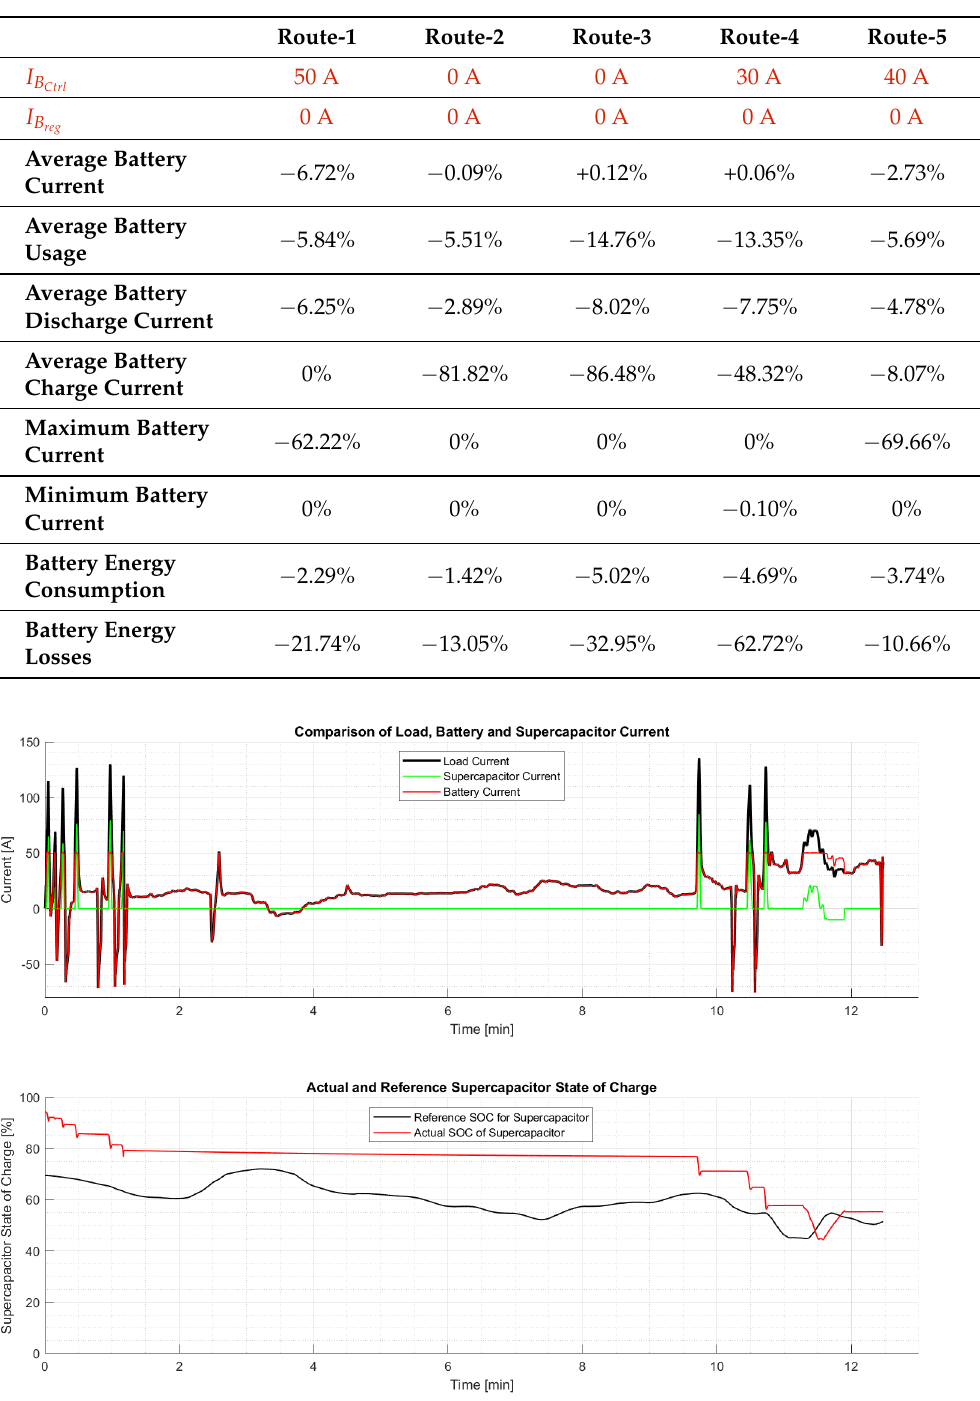
Table 4. Relative deviations between simulation of the battery and the HESS with energy management with route specific parametrisation to increase battery lifetime.